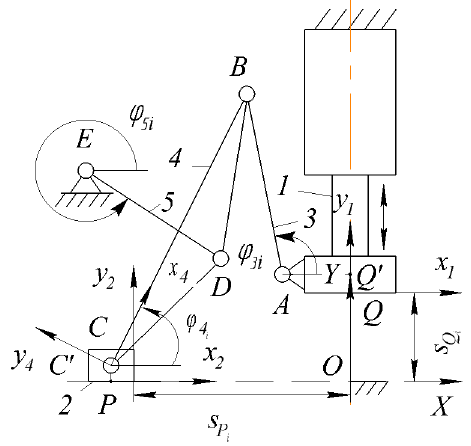
P х y with the sliders (Figure